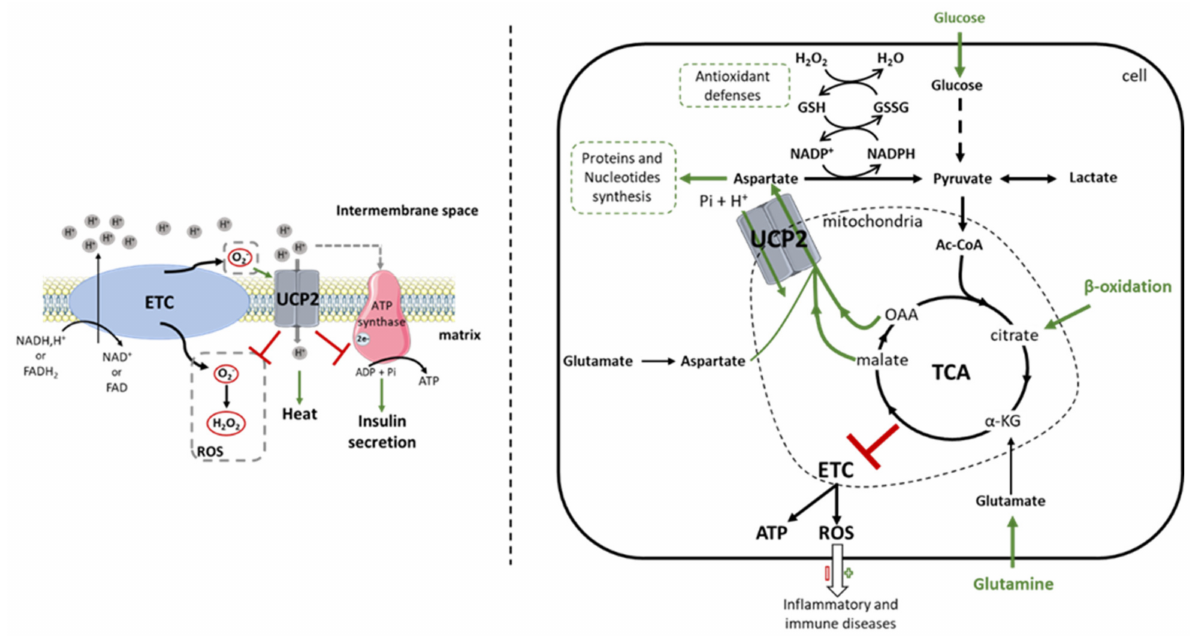
Figure 1. Comparison between the first function attributed to UCP2 and the new concept of mito- chondrial transport highlighted by the work of the Fiermonte team. Since its discovery, the UCP2 protein has been the subject of much controversy regarding its biochemical function. UCP2 was initially identified as an uncoupling protein of the electron transport chain. Thus, the protein captures protons from the intermembrane space and dissipates them into the mitochondrial matrix. Increased thermogenesis, decreased reactive oxygen species (ROS) levels and ATP synthesis, which conse- quently reduce insulin secretion, are observed due to reduced membrane potential ( left ). However, the non-reproducibility of these results in different cells and tissues has questioned this function. Since then, work by Vozza et al. [22] in 2014 showed that UCP2 catalyzes the exchange of 4-carbon (C4) metabolites (oxaloacetate, malate, aspartate) from the tricarboxylic acid (TCA) cycle for a phos- phate and a proton. UCP2 then regulates pyruvate oxidation in the mitochondrial matrix, which promotes cell proliferation by providing building blocks and increases antioxidant defenses by reg- ulating glutathione oxidation. C4 transport also controls TCA cycle activity to avoid overload by the accumulation of intramitochondrial compounds. The redox pressure of the oxidative phospho- rylation is then attenuated, which limits the production of ROS more or less harmful in the fight against pathologies ( right ). Ac-CoA: Acetyl-CoA; ADP: adenosine diphosphate; ATP: